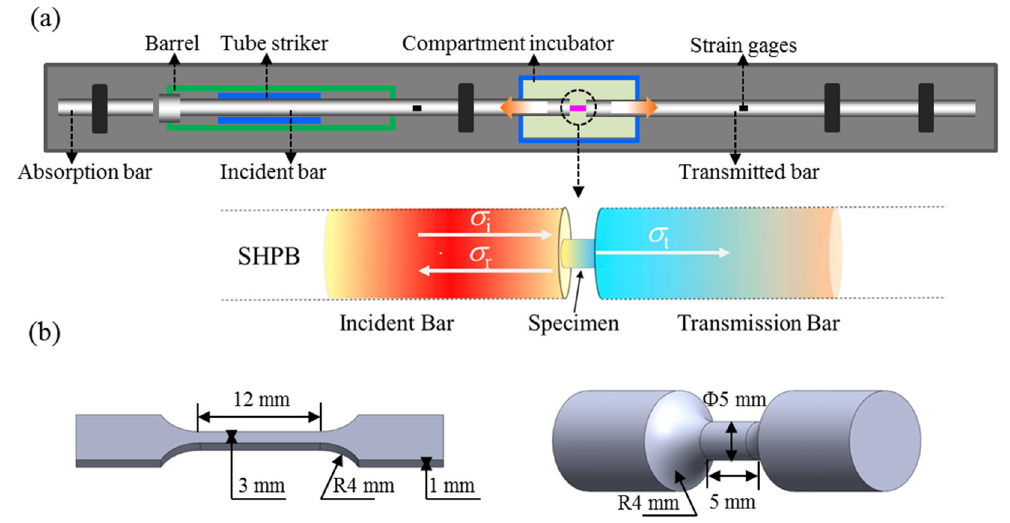
Figure 3. Schematic of split Hopkinson tensile bar (SHPB) and stress wave history during dynamic tension ( a ) and ( b ) the precise dimensions of the Ti alloy samples for quasi-static and dynamic tensile tests.